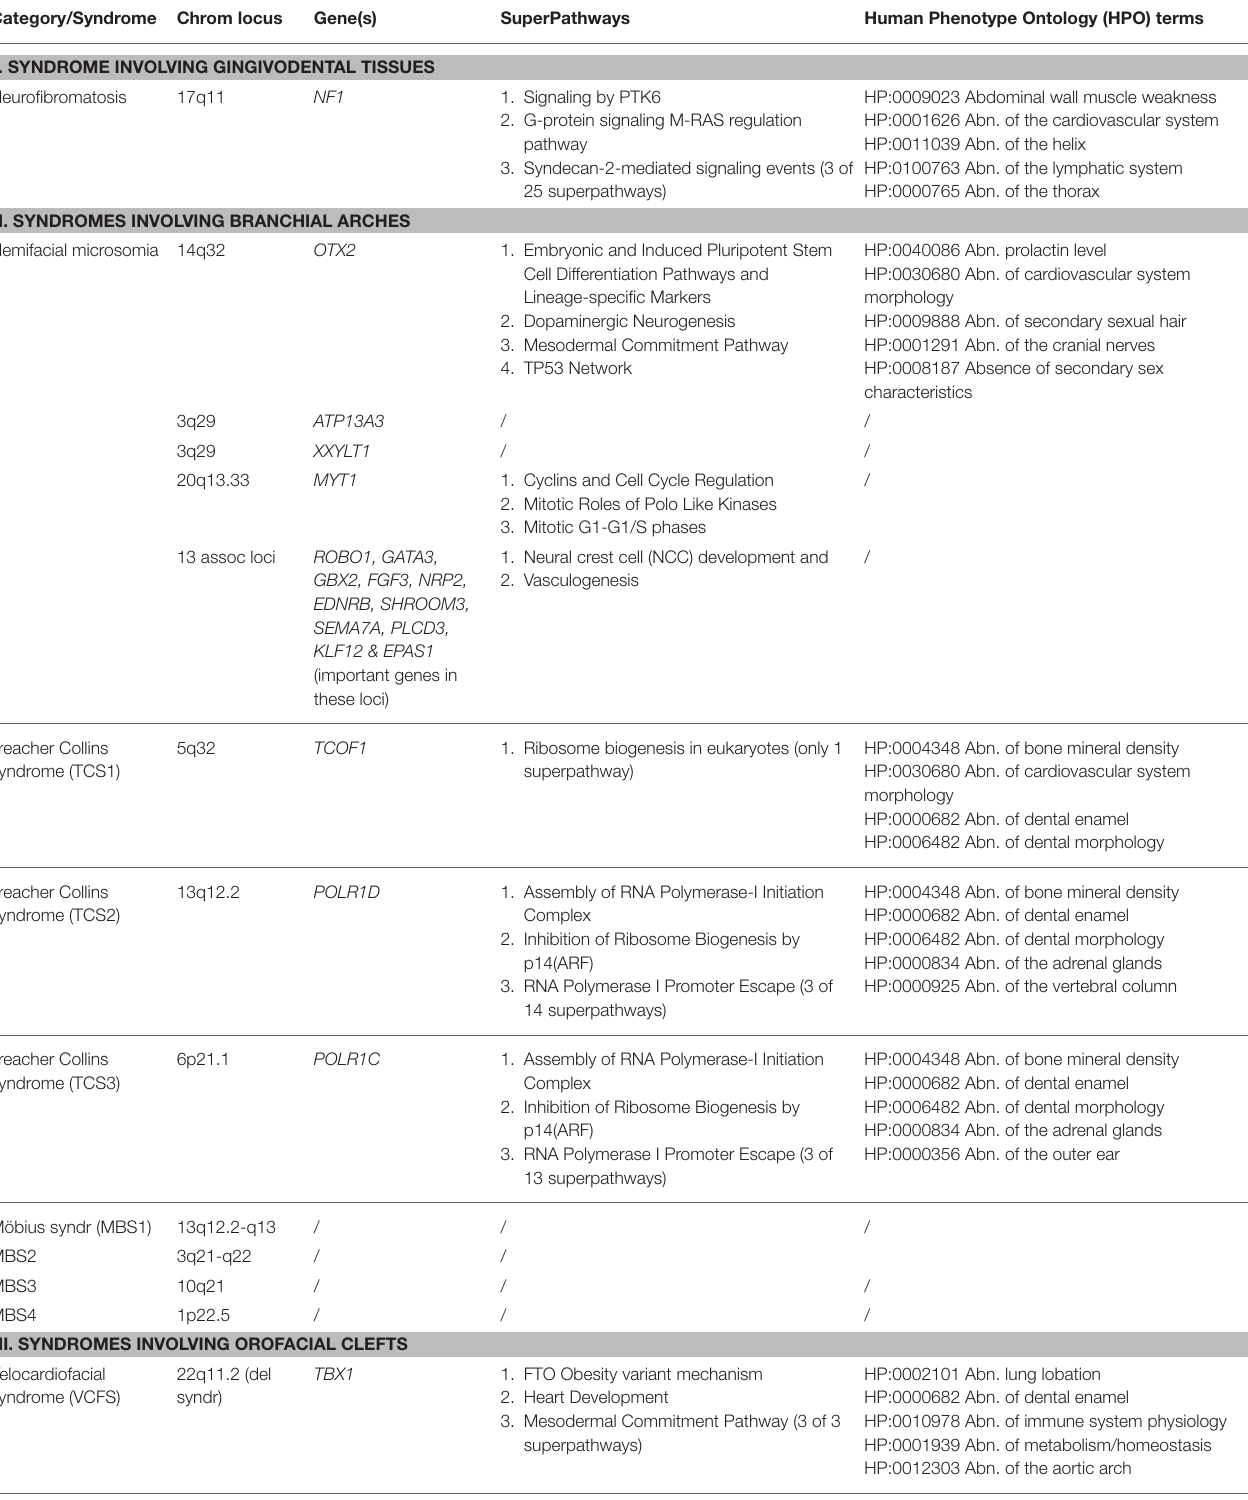
TABLE 1A | Genes, Genomic Locations, prioritized (Super) Pathways, and Human Phenotype Ontology (HPO) terms (original citation: current source: http://pathcards.genecards.org/Search/Results?query=gene) for each of the 13 selected syndromes (with 21 entities). Category/Syndrome Chrom